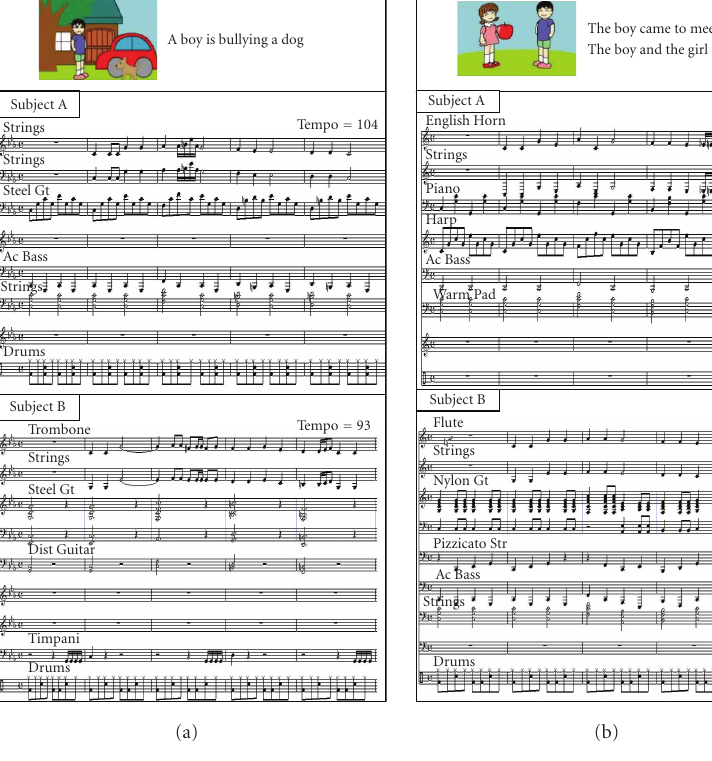
Figure 10: Examples of variations.